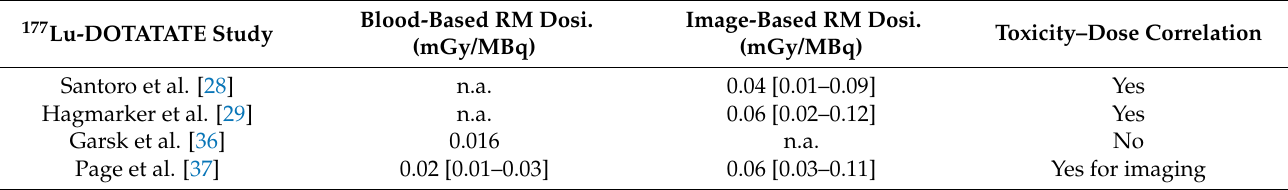
Table 1. Blood and image-based RM dose